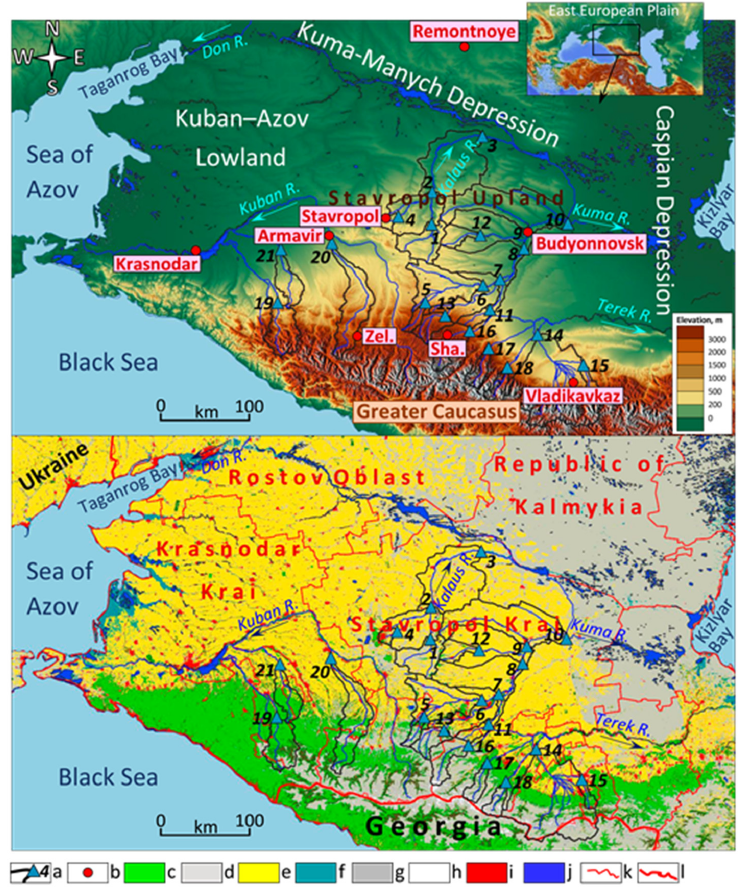
Figure 1. The study region with the analyzed objects. a—analyzed hydrological stations (with river basin borders) on the main studied rivers: Kaláus River at : 1 —Sérgiyevka, 2 —Svetlográd, 3 —